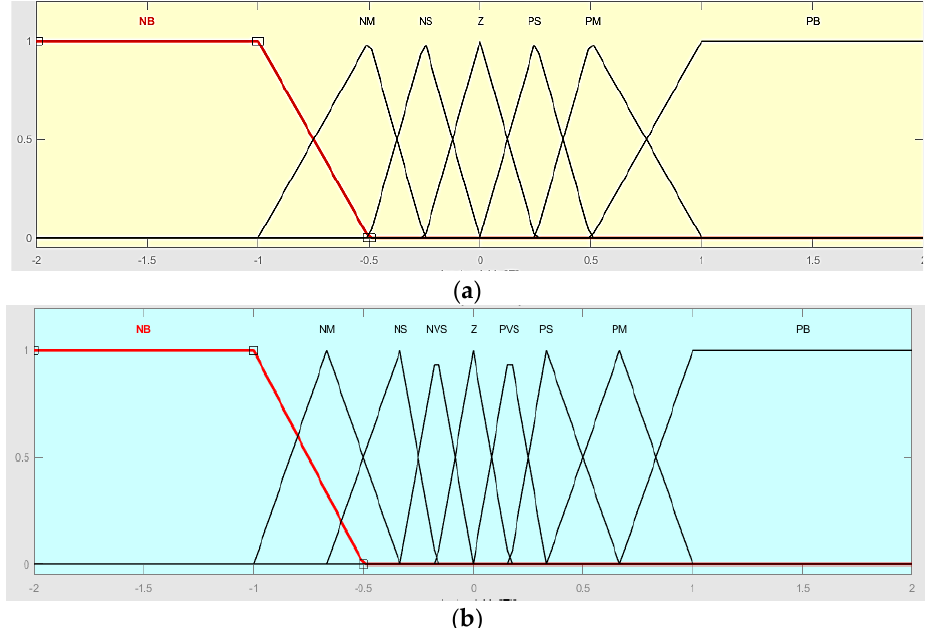
Figure 14. Membership functions for ( a ) error and change in error, and ( b ) output. Table 5. Rule base for fuzzy logic, controller-based induction motor drive.